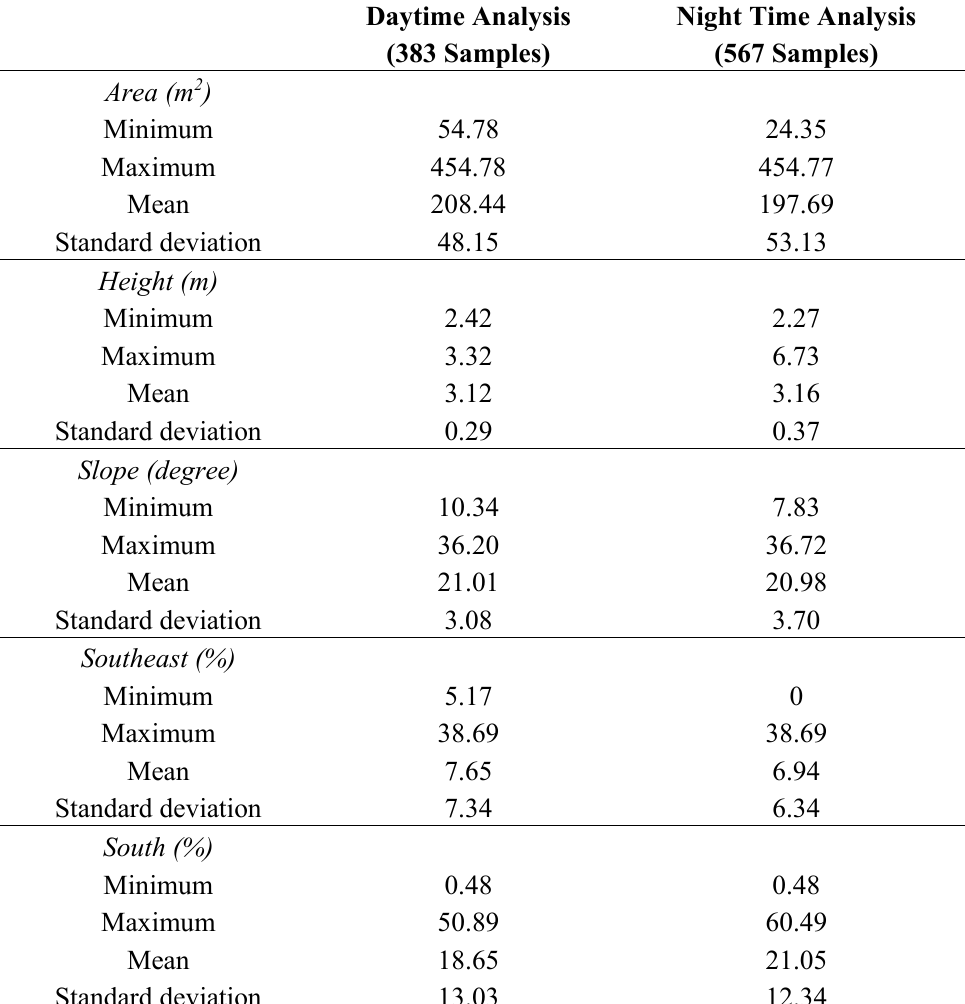
Table 2. Statistics of the selected rooftop